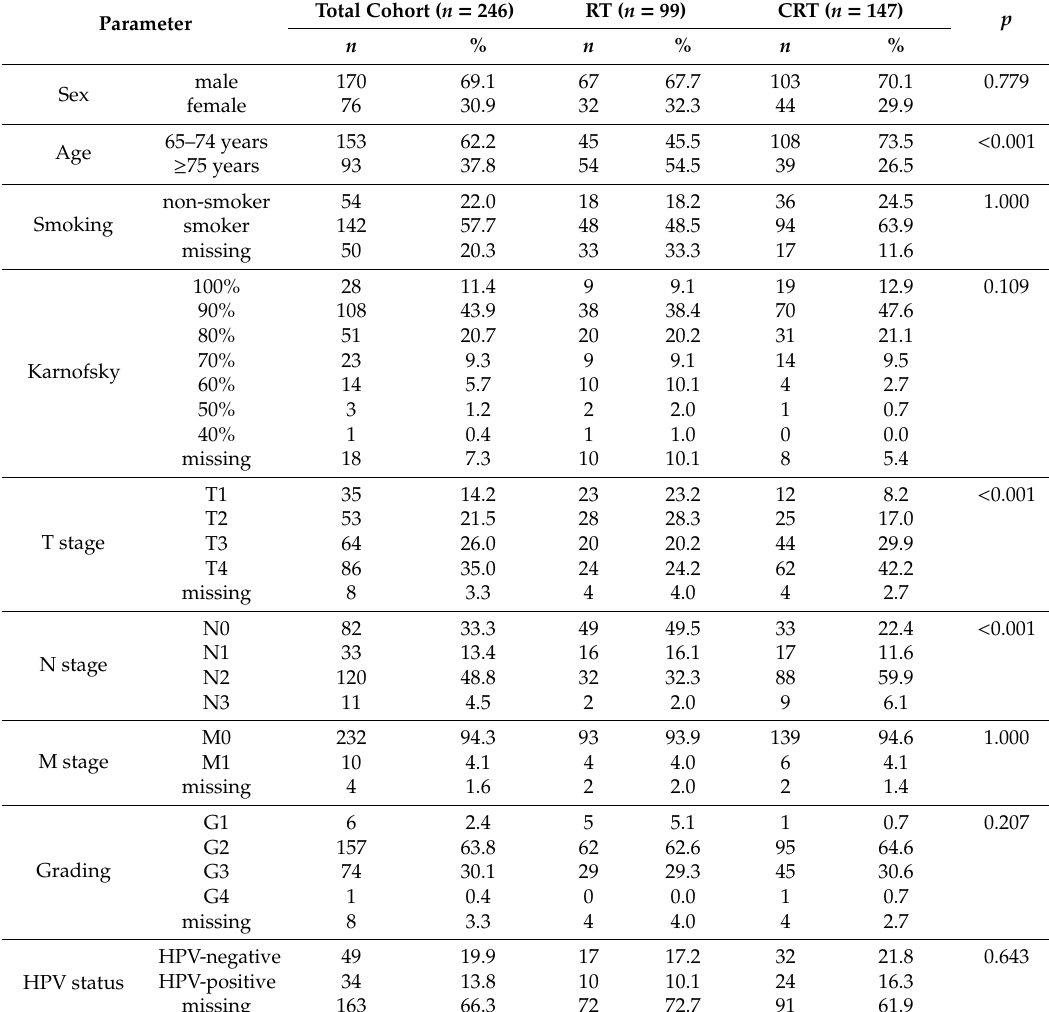
Table 1. Patient characteristics of 246 elderly HNSCC patients undergoing (chemo)radiotherapy between 2010 and 2018 ( n = 246). p -values are derived from Fisher’s exact tests in order to compare the radiotherapy (RT) with the chemoradiotherapy (CRT)